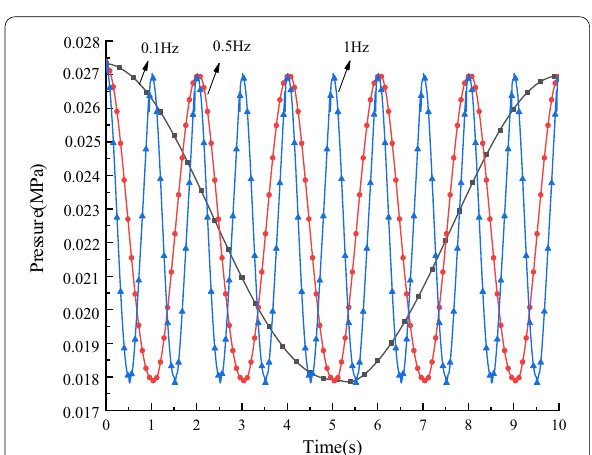
Figure 19 Changes in pressure at different